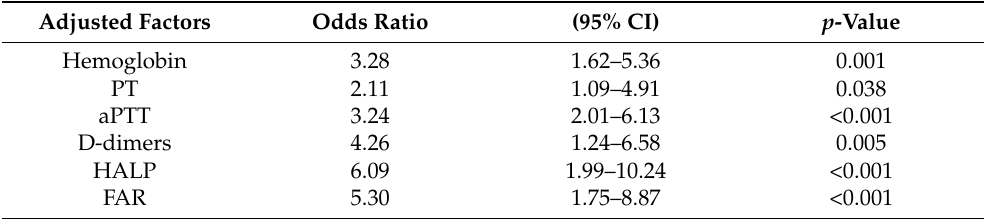
Table 4. Regression